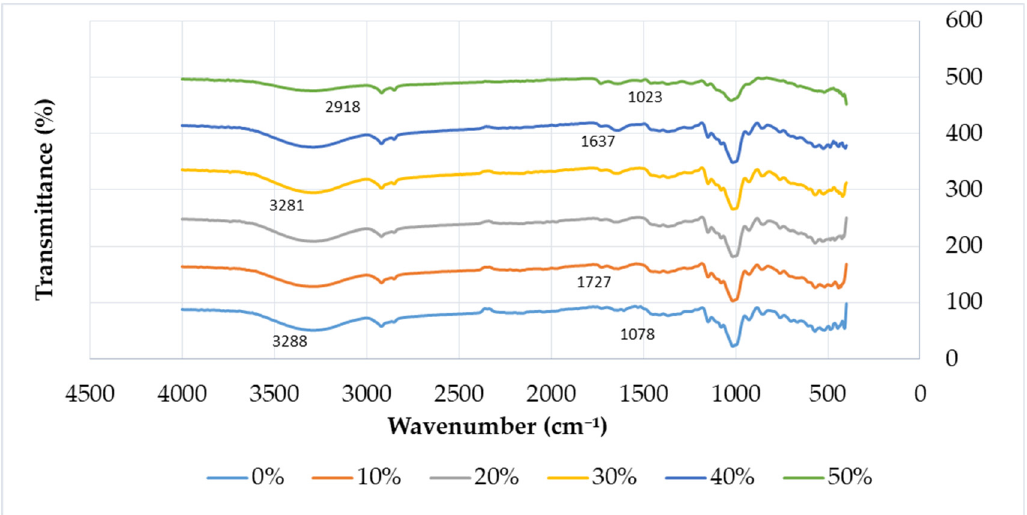
Figure 7. FT-IR spectra of TPCS + banana leaf fibre.